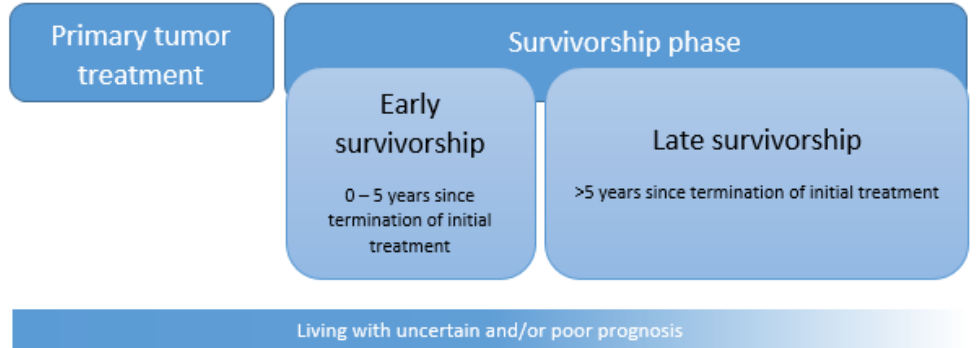
Figure 1. Primary tumor treatment, early survivorship, and late survivorship, partially adapted from the American Cancer Society [11]. Survivorship starts at the termination of the initial treatment. In the case of long-lasting adjuvant hormonal treatment after initial adjuvant chemotherapy, survival time, in our definition, starts at the end of chemotherapy. During survivorship, survivors attempt to transition to the ‘new normal life’, which can be subdivided into early and late survivorship [12]. Early survivorship covers the first 5 years since the termination of initial treatment [excluding maintenance therapy] and late survivorship from 5 years onwards since the end of initial treatment. For patients with a poor prognosis at diagnosis, survivorship starts at diagnosis. They have to live with a life-limiting disease.